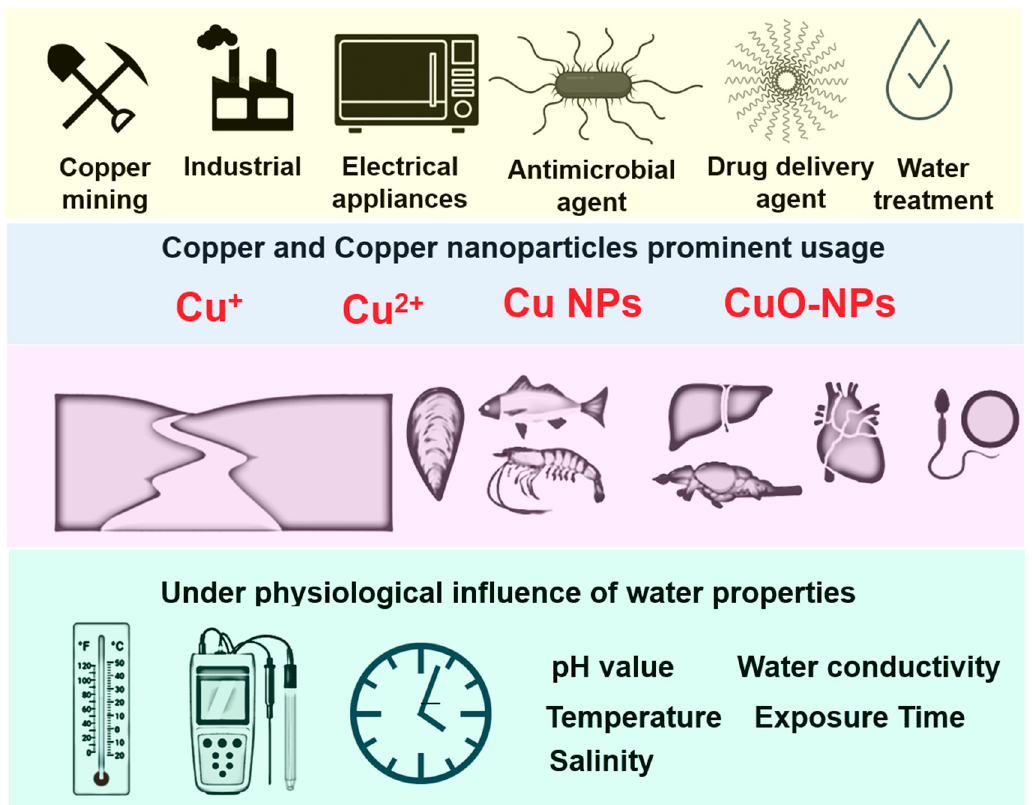
Figure 1. The schematic diagram depicts the bioavailability of current and potential applications of copper and copper nanoparticles, the main forms of copper that interact with biota, and the major parameters that influence copper toxicity. The top yellow panel shows the potential sources of copper and copper nanoparticle (CuNP) pollution that are generated in our daily lives. The middle blue panel shows the potential form of copper pollution in terms of Cu(I), Cu(II), Cu nanoparticles, or CuO nanoparticles. The middle pink panel shows the copper and copper nanoparticles that are released into water and subsequently ingested by aquatic animals and deposited in internal organs such as the liver, brain, heart, and reproductive organs. The bottom green panel shows the physical properties of water, like the pH value, temperature, salinity, water hardness, and exposure time, which can influence the copper and copper nanoparticle toxicity.